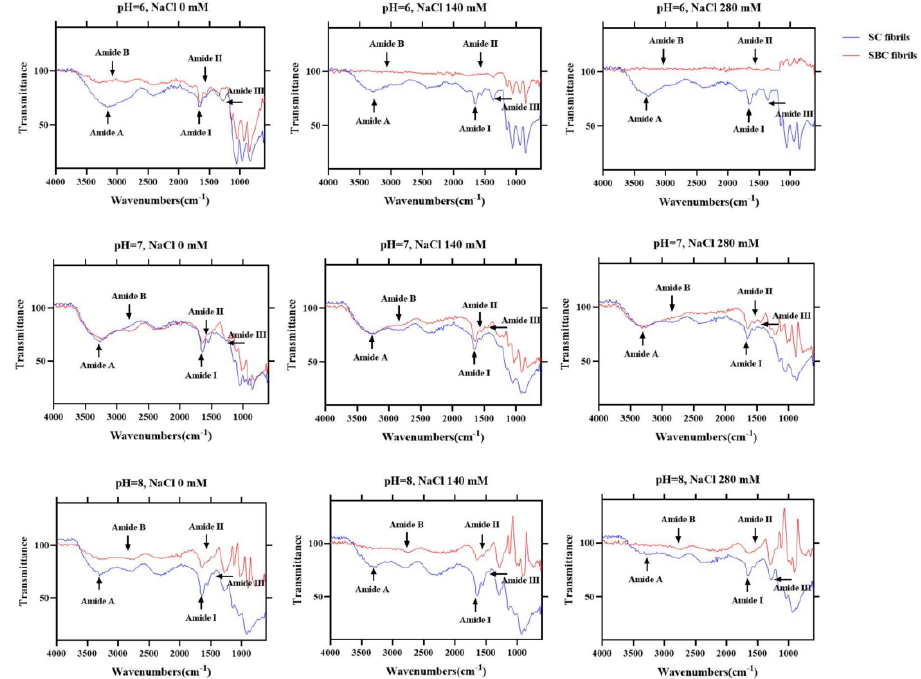
Figure 7. FTIR spectra of skin collagen (SC) fibrils and swim bladder collagen (SBC) fibrils from C. idella under different salinity and pH: ( A – I ) collagen with NaCl concentrations of 0, 140, and 280 mM and pH 6, 7, and 8.